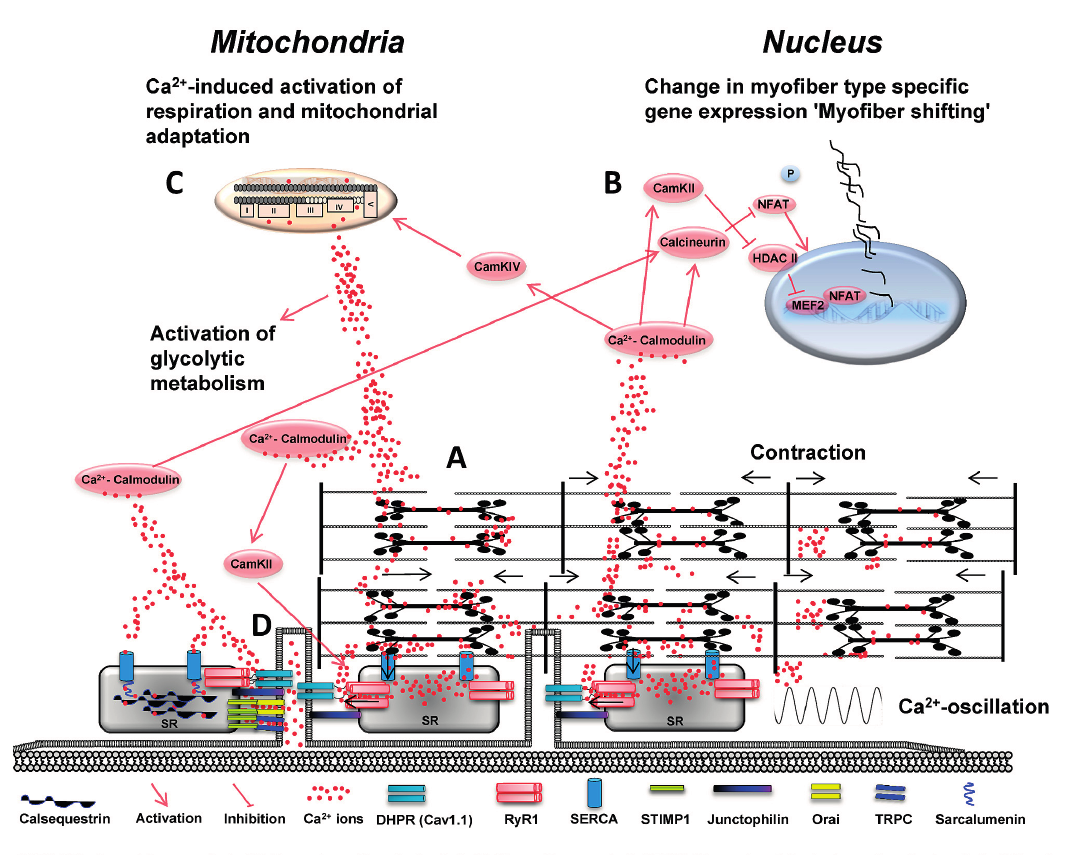
Figure 1. ( A ) Voltage-dependent activation of the dihidropyridine receptor (DHPR-Cav1.1) facilitates the release of Ca 2+ ions out of the sarcoplasmatic reticulum (SR), which critically regulates skeletal muscle contraction. Reuptake of Ca 2+ ions in the SR controls skeletal muscle relaxation and is mainly regulated by ATP-dependent sarcoplasmic/endoplasmic reticulum calcium ATPase pumps (SERCA1/2). Increased neuromuscular activity establishes an oscillating pattern of Ca 2+ ion levels and causes elevated sarcoplasmic Ca 2+ ion concentrations in the microenvironment of myofibrils; ( B ) Increasing levels of Ca 2+ ions in the sarcoplasm bind to and activate calmodulin (CaM) which regulates activation of calcineurin and calmodulin kinase II and IV. Calmodulin kinase II (CaMKII) contributes to the phosphorylation of ryanodine receptor 1 (RyR1) which increases RyR1 channel activity and open probability. CaMKII further inhibits histone deacetylase II (HDACII) and increases nuclear abundance of myocyte enhancer factor 2 (MEF2). Calcineurin (CaN) dephosphorylates nuclear factor of activated T-cells (NFAT) hereby regulating its